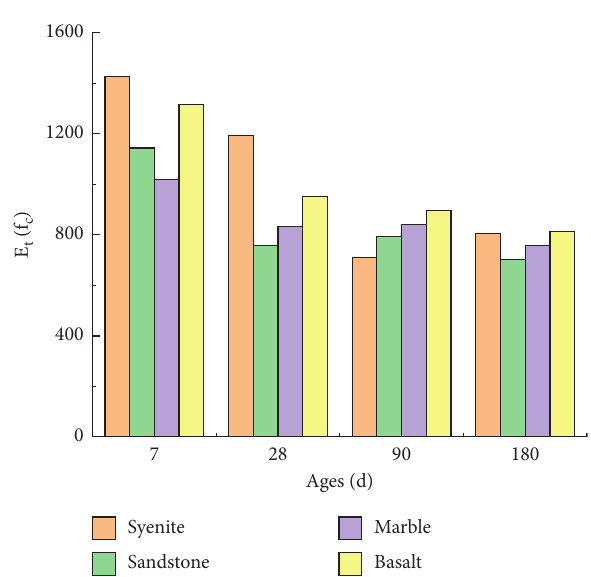
Figure 5: E c / f c of four types of aggregate concrete.